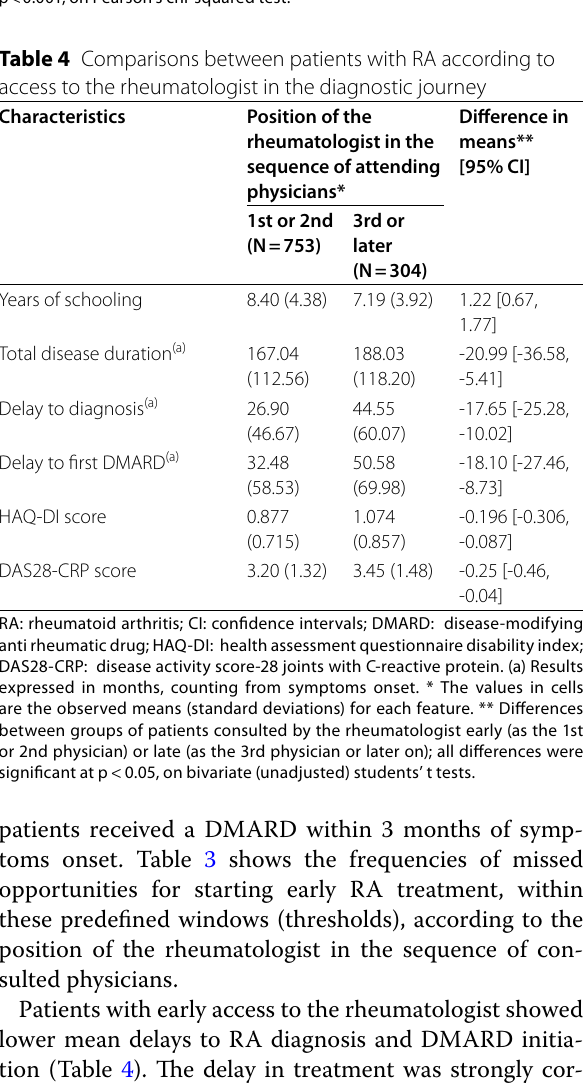
the sequence of attending physi- cians *